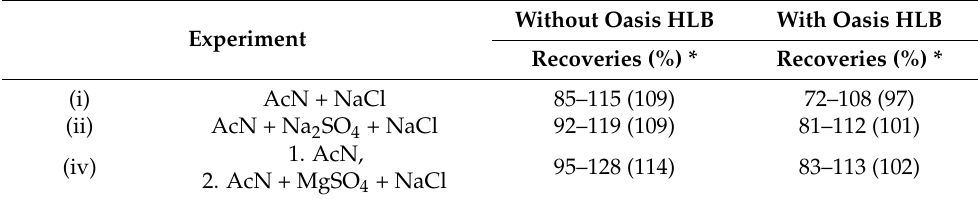
Table 2. Matrix-effect (%) at